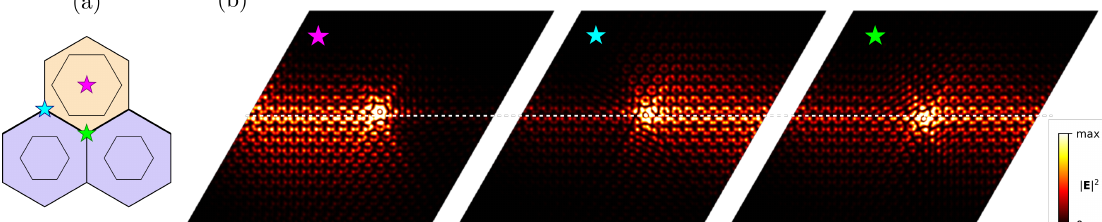
Figure A4. Breathing honeycomb photonic crystal interface. ( a ) Left circularly-polarised sources are placed at three positions near the interface. ( b ) Electric field intensity | E | 2 for the different source positions, demonstrating source position dependent